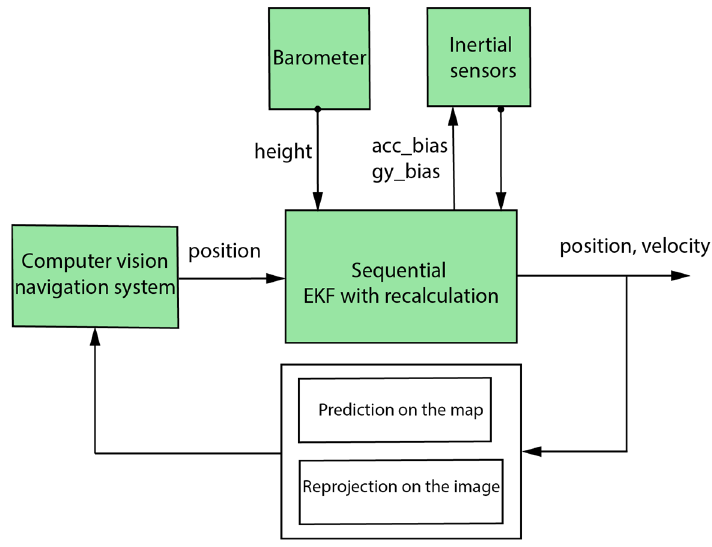
Figure 2. General diagram of the mutual aiding-based navigation system.